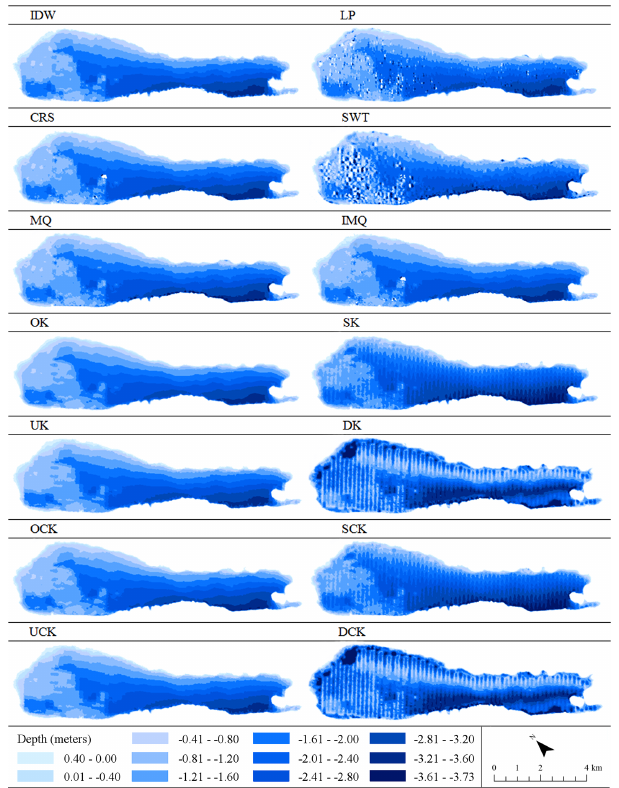
Figure 7. Digital elevation models generated from surveyed data, showing differences between deterministic and geostatistical inter- polation methods.